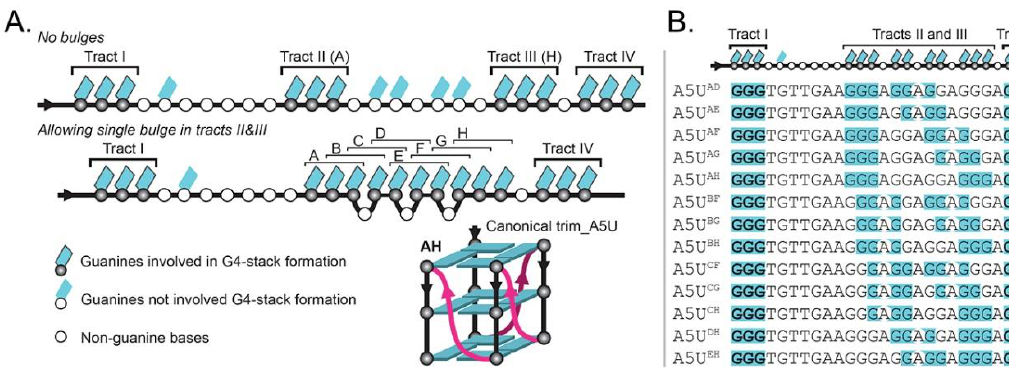
Figure 6. Extended model of G4 formation by trim_A5U allowing one bulge in G-tract. ( A ) Comparison between the canonical model and the extended G4 model. The extended model allows longer loops and a one-base-bulge interruption of G-tracts. Under the canonical model there is only one possible fold that can be adopted by trim_A5U to form a G4 core using tracts that do not contain bulges (i.e., tracts II (labeled A) and III (labeled H)). Under the extended model, trim_A5U can potentially form 13 different G4 core folds (including a canonical fold A5U AH ) with fixed tracts I and IV and the potential of one-base bulges in tracts II and III. ( B ) Guanines that can be involved in formation of the G4 core in the extended model are highlighted. Table 1. Summary of the properties of trim_A5U-locked variants. Gs that participate in G4 formation are in bold and G-tracts are underlined and bold. Mutated residues are in lowercase.